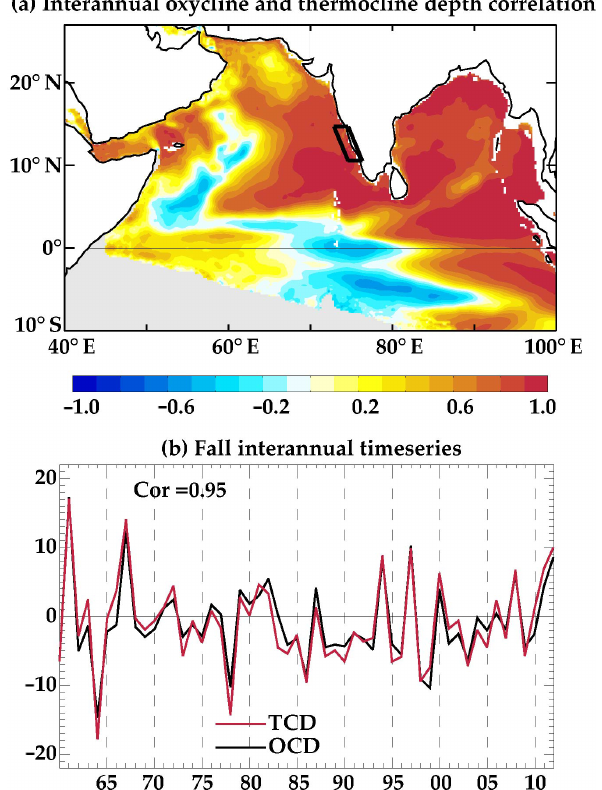
Figure 8. (a) Map of correlation between the modeled oxycline and thermocline depth fall interannual anomalies. (b) Time series of fall interannual anomalies of the modeled TCD (m; red line) and OCD (m; black line) averaged over the WCI box (see frame in panel a ). In panel (a) , values are shaded grey when the oxycline and/or thermo- cline could not be defined (with their present definition) for more than 20% of the profiles at a given location.